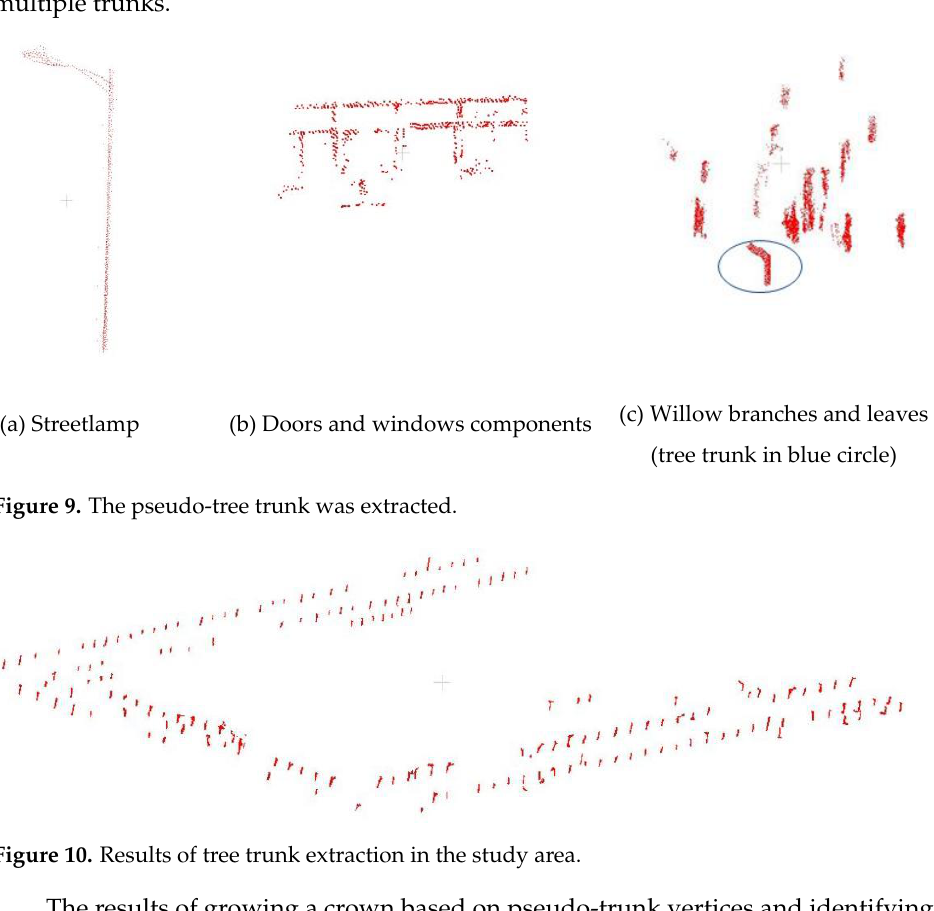
Figure 8. Tree trunk extraction by the GDRG algorithm.